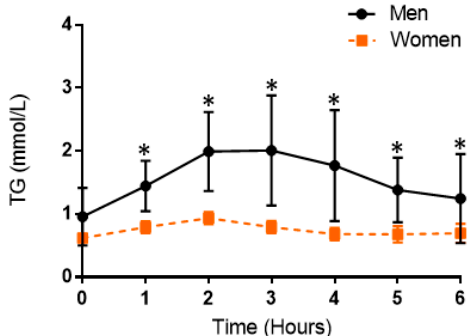
Figure 4. Consolidated postprandial responses in triglycerides in men and women. Average TG responses across meal trials at baseline and hourly throughout the postprandial period in men and women. Data are presented as mean ± SD. * Indicate differences between men and women at a specific time point ( p < 0.05) based on post hoc pairwise comparison. TG, triglycerdes; B, butter; CoO, coconut oil; OO, olive oil; CaO, canola oil.